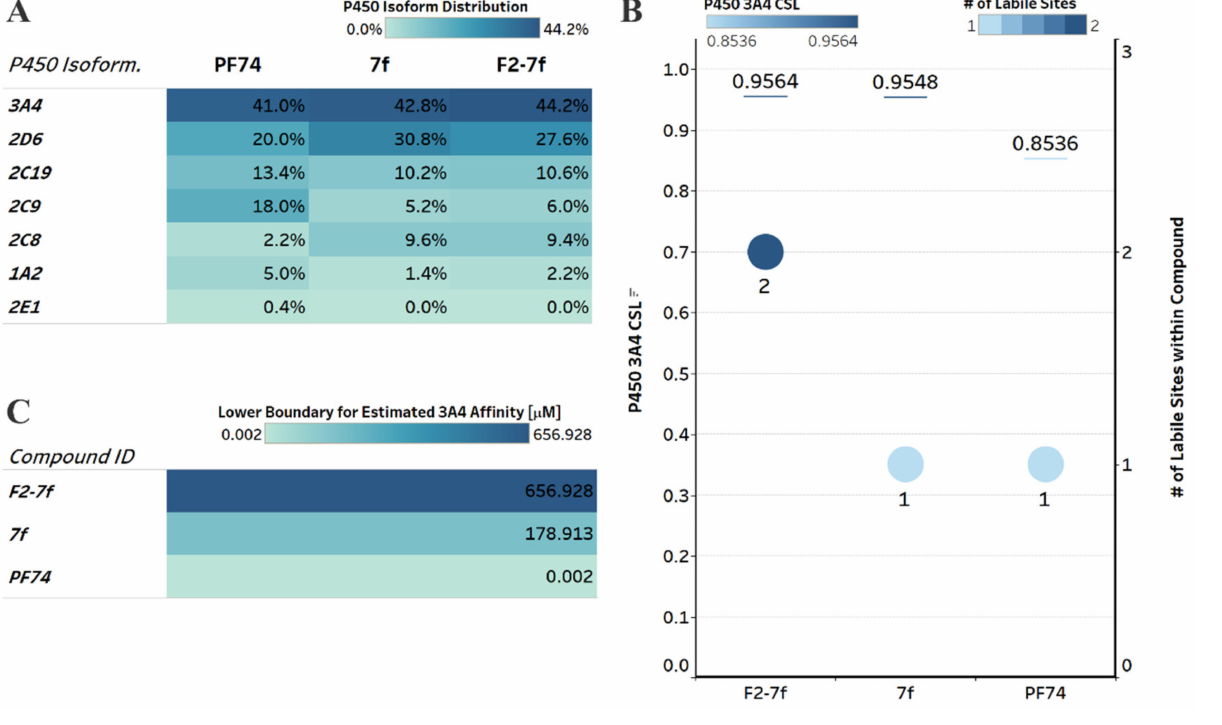
Figure 7. Computational prediction of metabolic stability. ( A ) Prediction of the major metabolizing CYP isoforms. All compounds are predicted to be metabolized primarily by the 3A4 isoform, including PF74 . ( B ) Overall composite site lability (CSL) score and number of labile sites within the compound (for metabolism). A lower CSL score indicates a more stable molecule. The prediction was achieved using the StarDrop (version 7) P450 module. ( C ) Predicted affinity of docked 7f, F 2 -7f , and PF74 to Cytochrome P450 3A4 (PDB ID: 4D78). The lower boundary for predicted 3A4 affinity utilized the hydrogen bond and dehydration scoring function (HYDE) implemented in